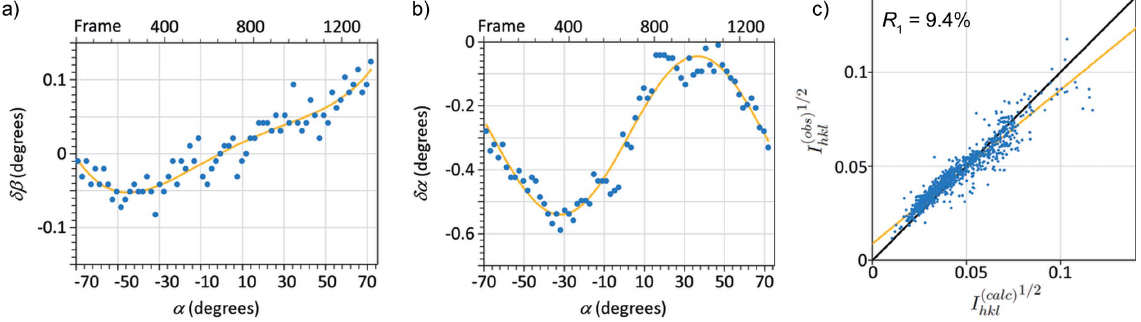
Figure 9 Corrections to the nominal direct beam path (red line in Fig. 5), ( a ) perpendicular to the line ( (cid:9) tilt) and ( b ) along the line ( (cid:5) tilt). The uncertainty in (cid:7)(cid:5) and (cid:7)(cid:9) for each data point is (cid:2) (cid:10) 0.5 frames, i.e. 0.05 (cid:3) . ( c ) R 1 calculation after correcting the integrated intensities for a varying slew rate gives R 1 = 9.4% at a specimen thickness of 195